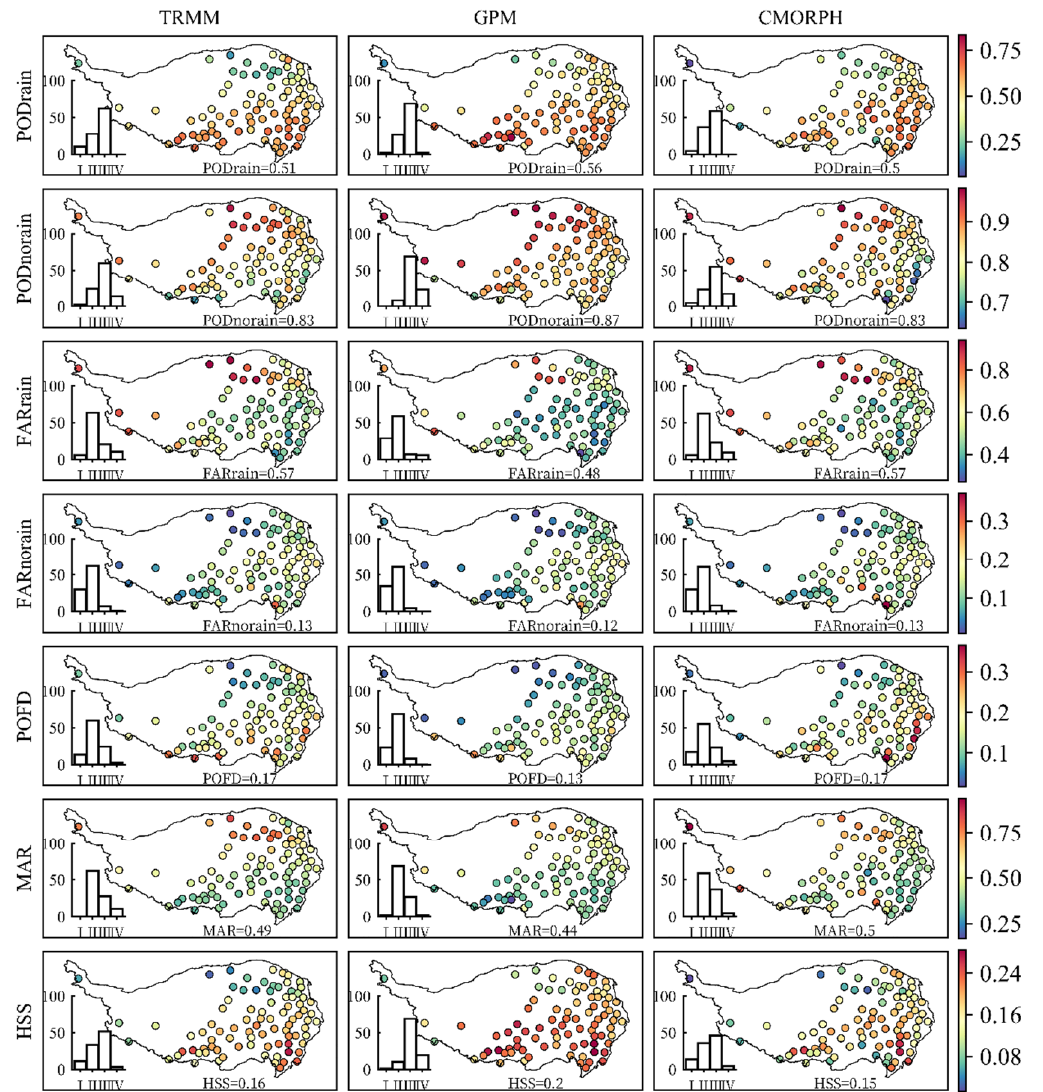
Figure 12. Spatial distribution of capturing-capability indexes from the three remote sensing precipi- tation products and the percentage of evaluation points in different intervals. I, II, III and IV indicate the different intervals of the indexes (see Table 2), and the marked numbers represent the average values of the evaluation indexes. Table 2. The indicted range for each evaluation index interval.